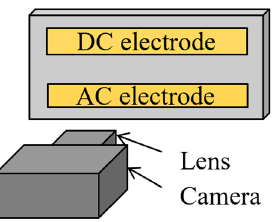
Figure 4. Schematic of discharge photograph imaging.